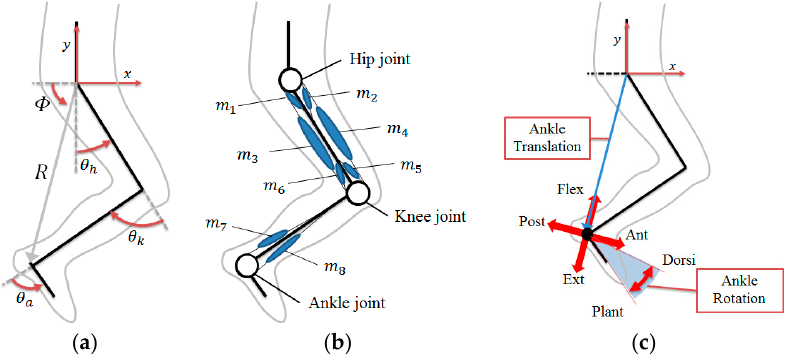
Figure 1. Definition of musculoskeletal model of lower limb. ( a ) Kinematic joint angle and ankle position. ( b ) Measuring muscles. ( c ) Ankle translation/rotation, Ext/Flex, Ant/Post, and